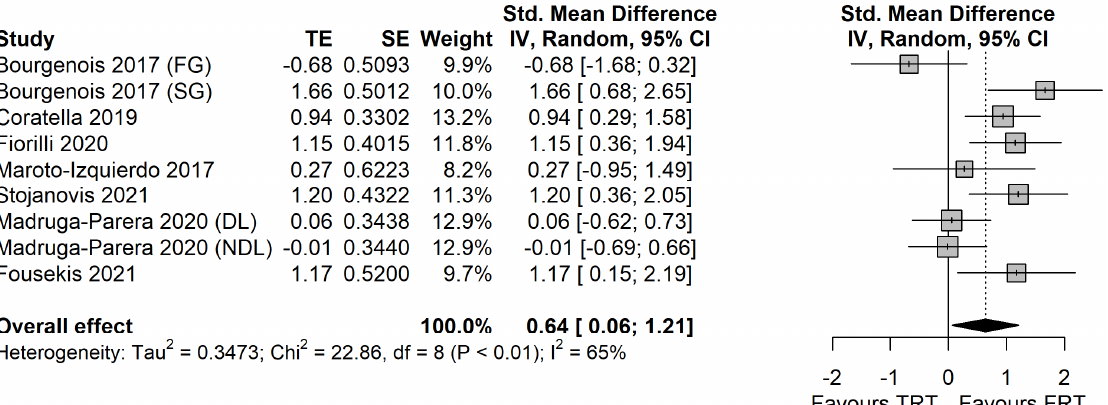
Figure 3. The effects of flywheel resistance training vs. traditional resistance training on change of direction performance in male athletes [22–28]. FG: fast group; SG: slow group; DL: dominant leg; NDL: non-dominant leg; RL: right leg. TST: traditional strength training; AET: accentuated eccentric training.